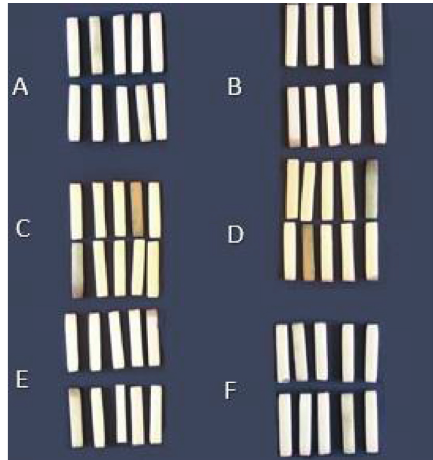
Figure 1: The specimens of three types of monolithic zirconia: (a) hightranslucent zirconia without APA, (b) high-translucent zirconia with APA, (c) low-translucent zirconia without APA, (d) low-translucent zirconia with APA, (e) multilayered zirconia system without APA, and (f) multilayered zirconia system with APA.